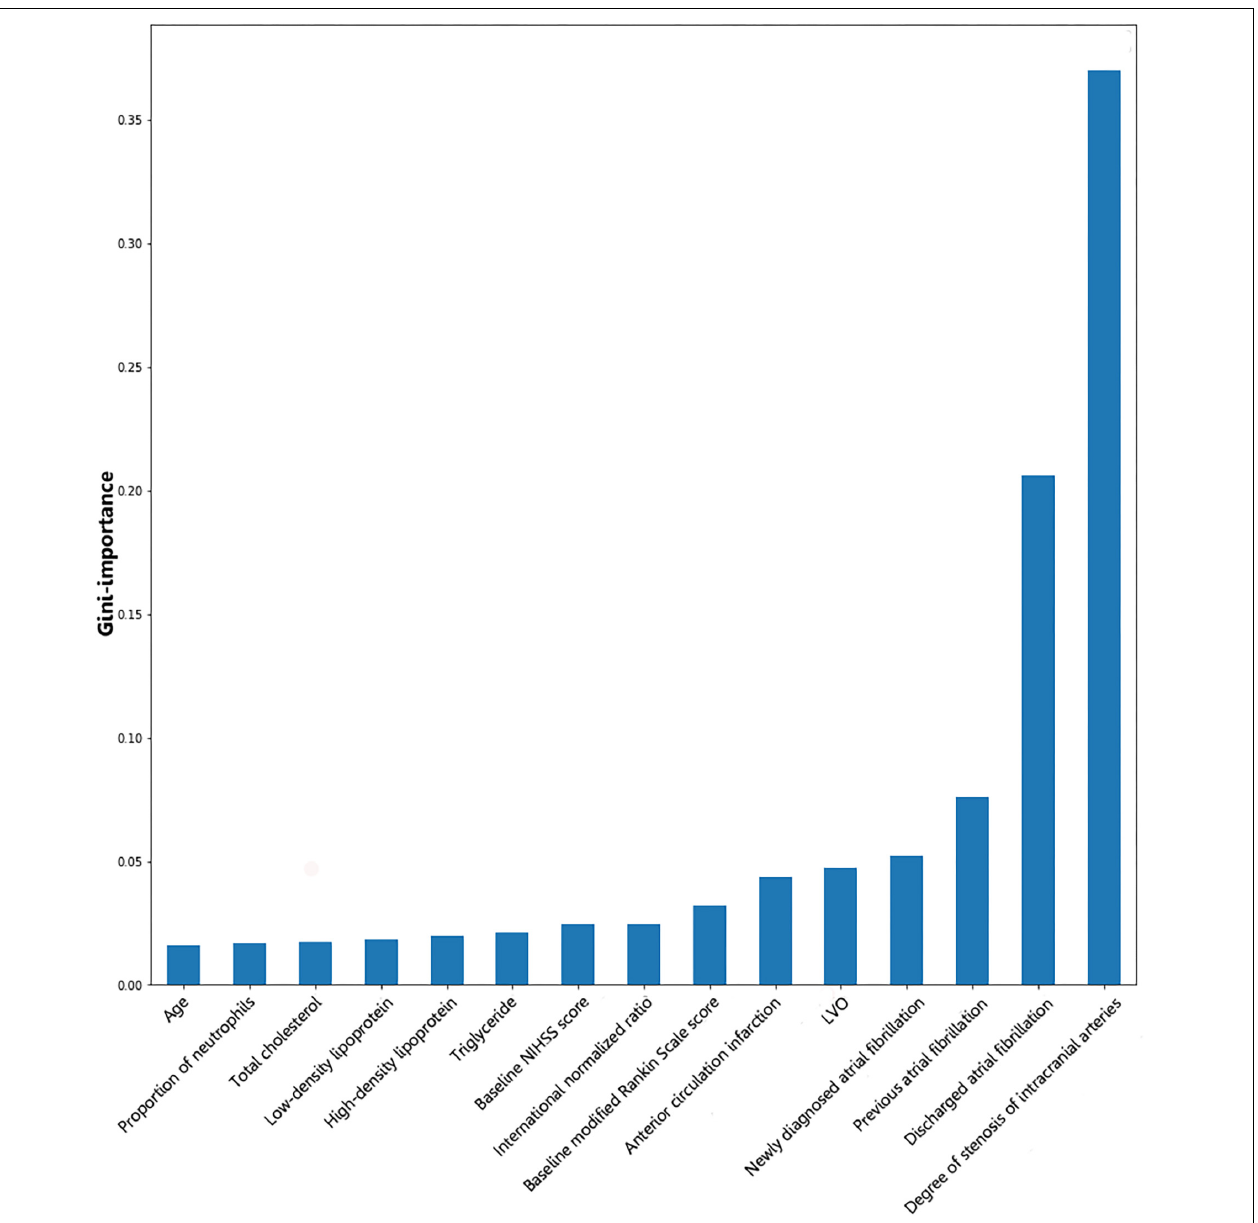
FIGURE 2 | Illustration of features contributing to the identification of LAA by Gini importance values. LAA, large-artery atherosclerosis; LVO, large vessel occlusion; NIHSS, National Institutes of Health Stroke Scale. Gini importance is a measurement of the feature importance in the model; the higher the value of Gini importance is, the more important the feature